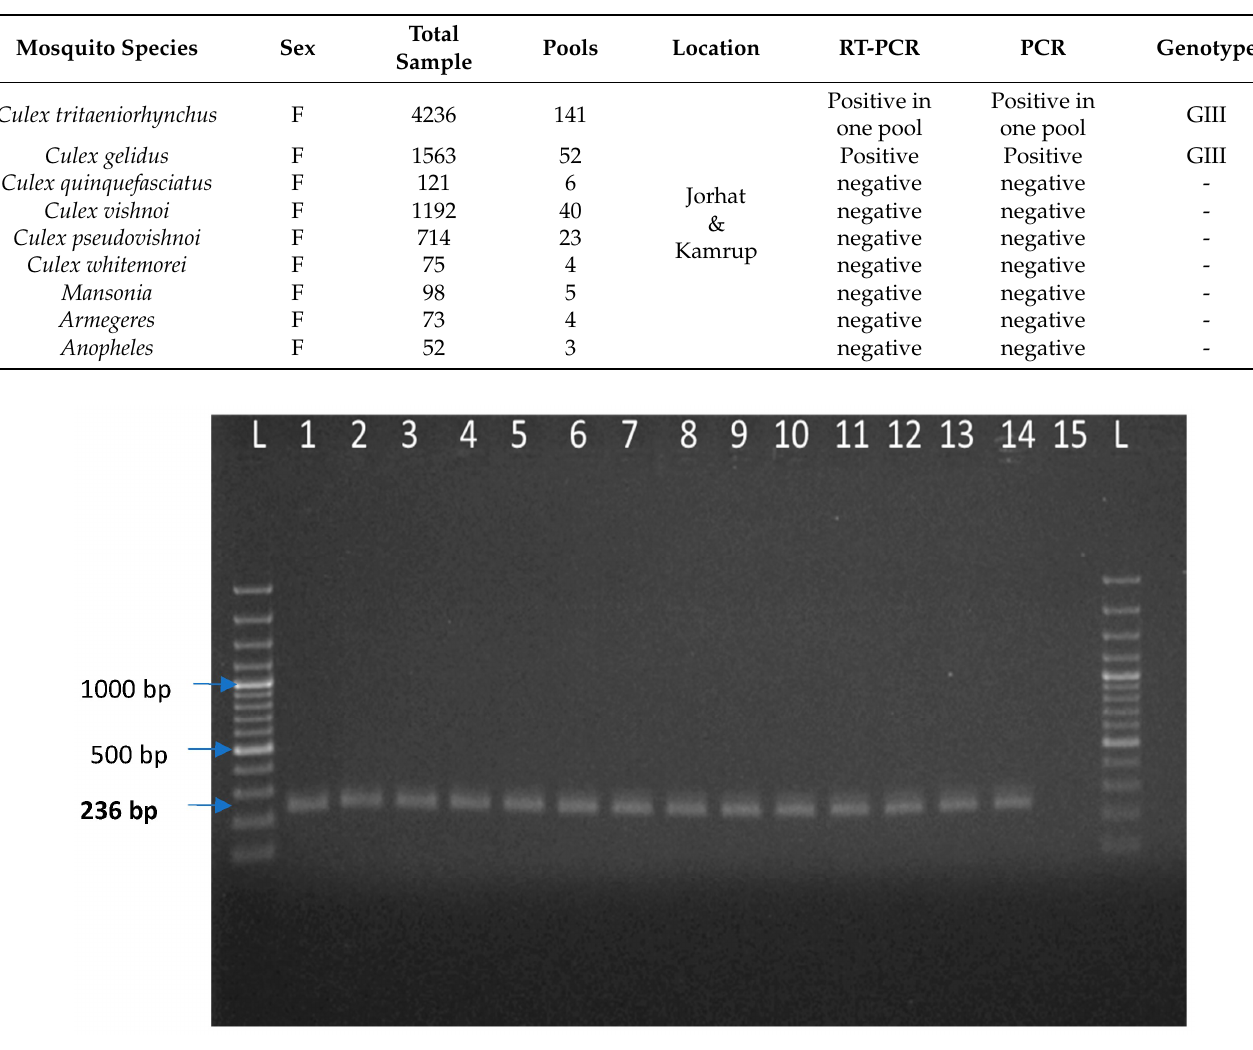
Figure 4. Agarose gel electrophoresis of JEV partial E gene amplified products isolated from pig and mosquito. Here, L: 100 bp plus ladder, 1: Positive control of JEV, 2 to 12: Test samples of JEV isolated from pig sources, 13 and 14: Test samples of JEV isolated from mosquito, 15: Negative control.